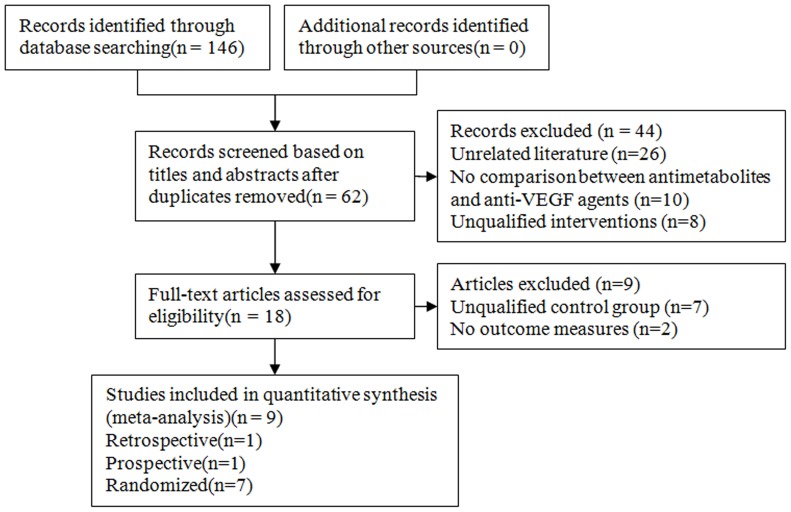
Flow chart of literature search and study selection.